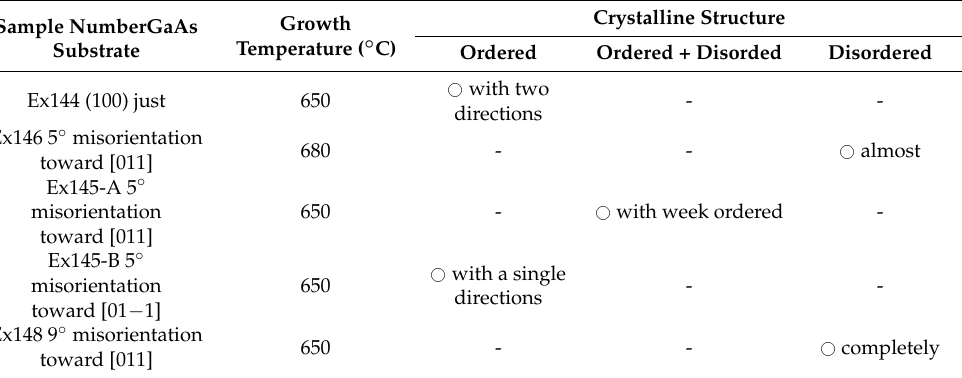
Table 1. Sample list of gallium indium phosphide (GaInP) epitaxial